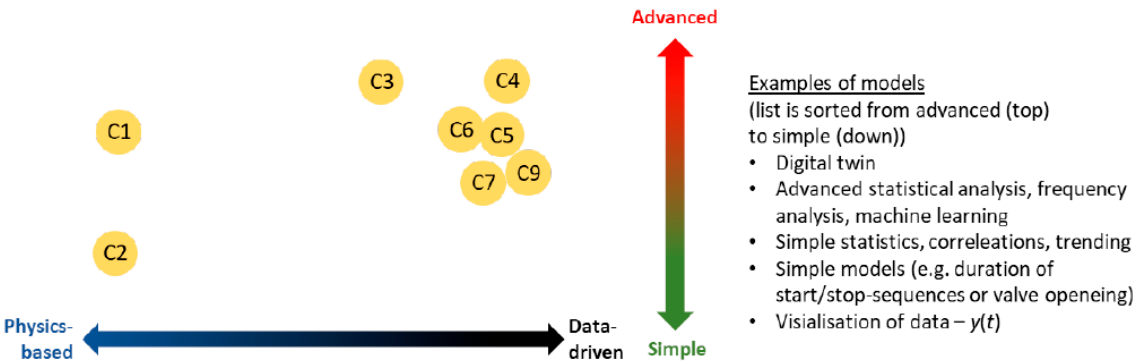
Figure 1. Classification of anomaly detection problems.